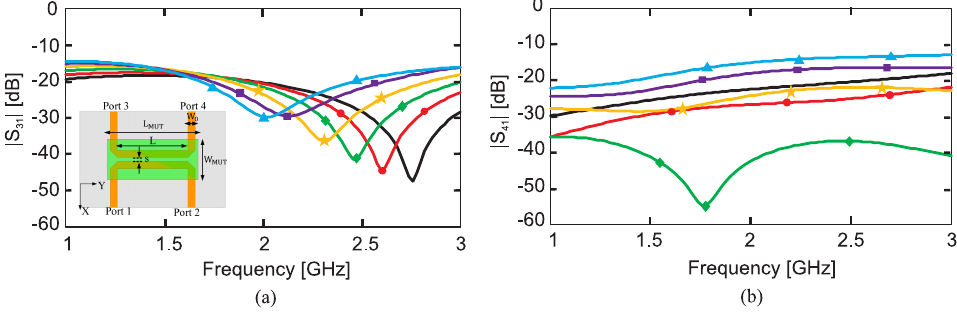
Figure 36. Simulated | S 31 | ( a ) and | S 41 | ( b ) of a classical microstrip coupled-line coupler when loaded with different MUTs. Reprinted with permission from Ref.